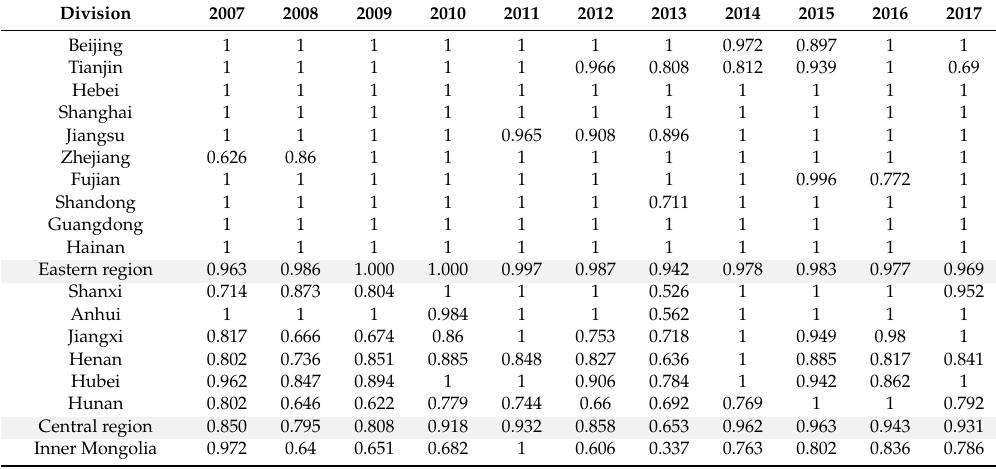
Table A3. Pure technical e ffi ciency values of fiscal policies for environmental pollution control in China